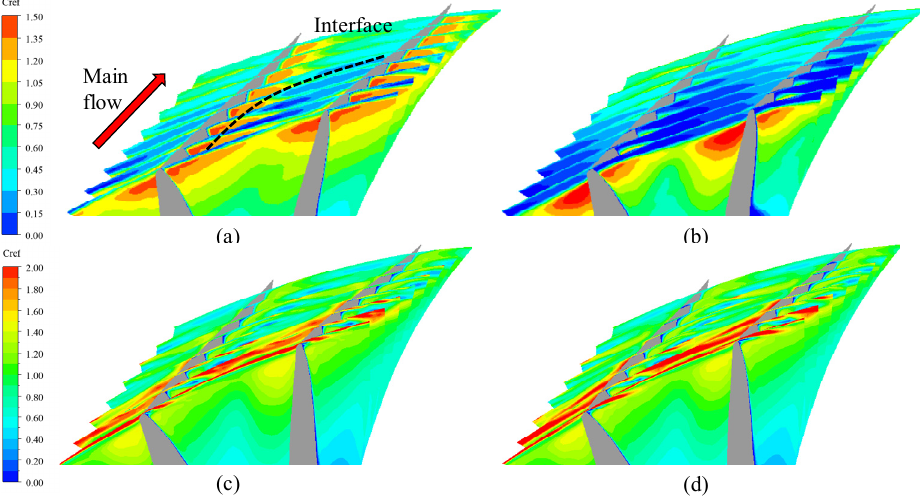
Figure 8. Contours of relative total pressure coefficient. ( a ) ORI; ( b ) SEI; ( c ) SES; ( d ) CCT.